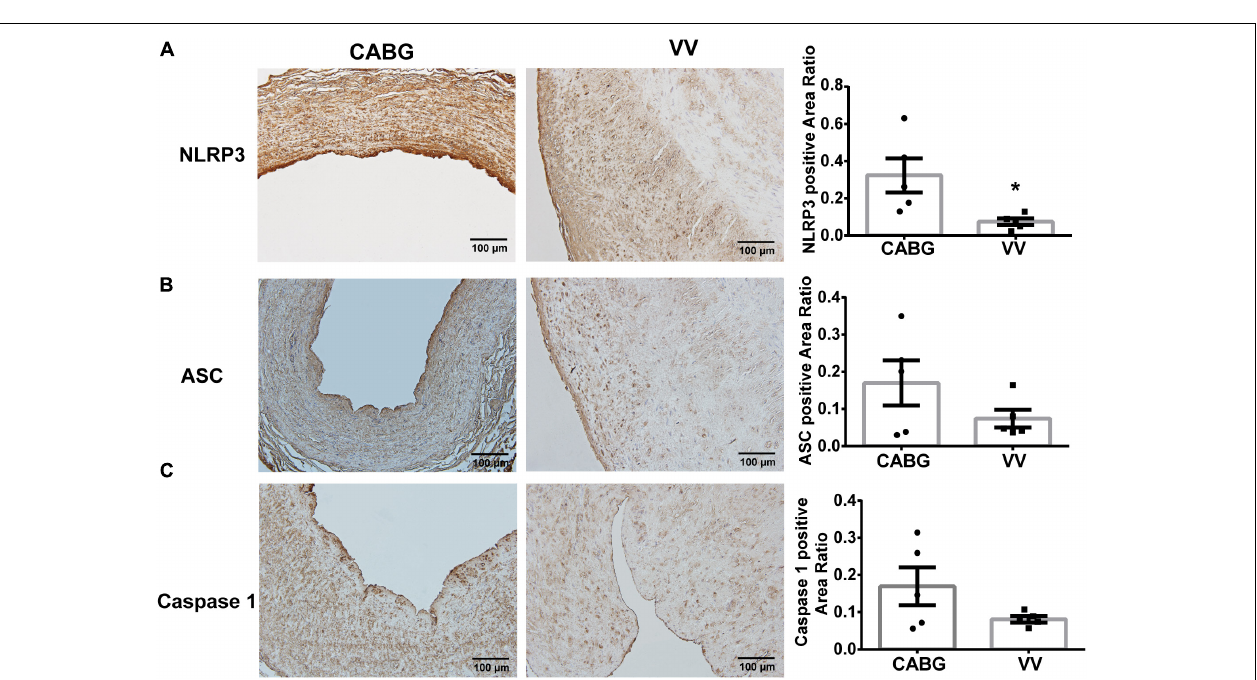
FIGURE 3 | Gene functional analysis of module gray genes. (A) Gene expression of module gray genes with RNA-seq data. (B) Gene ontology analysis of module gray genes.